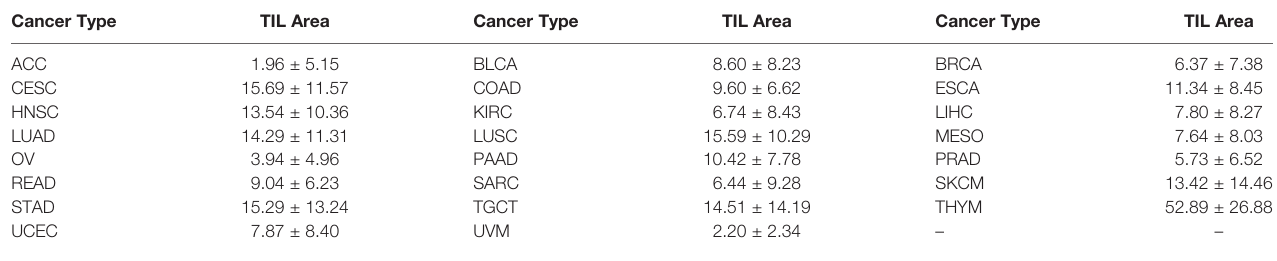
TABLE 4 | Estimated percent TIL area (mean±standard deviation) across WSIs in the dataset TIL-Maps-23. Cancer Type TIL